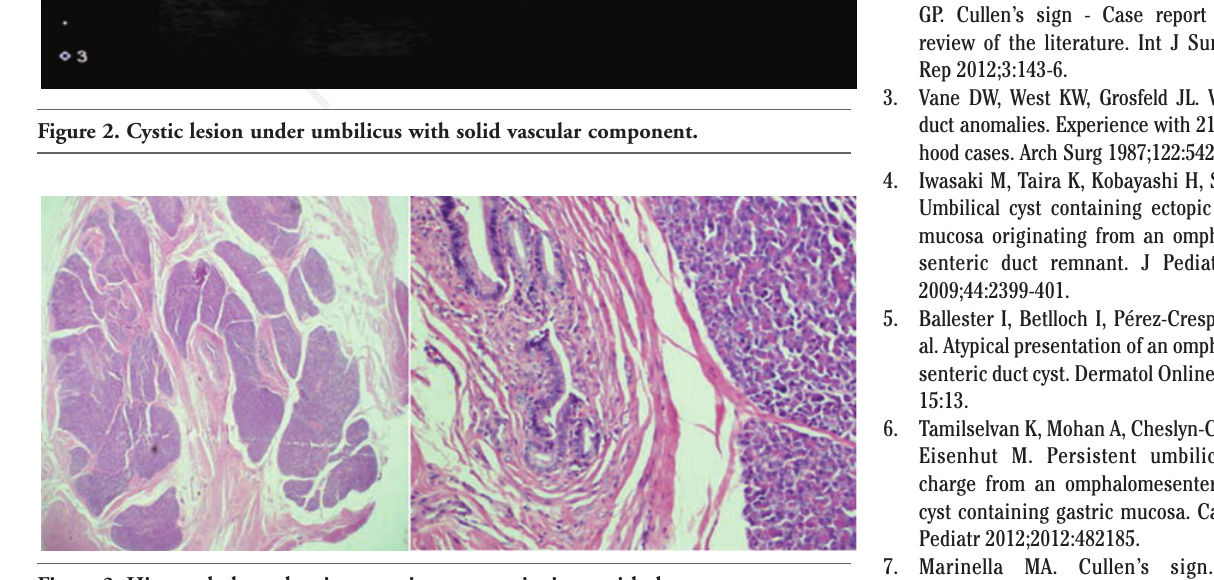
Figure 3. Histopathology showing exocrine pancreatic tissue with